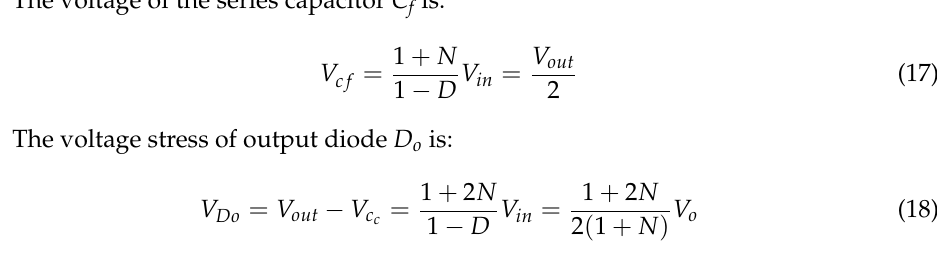
The relationship between output diode voltage stress and turns ratio is shown in Figure 7. The minimum output diode voltage stress ratio is 0.5. With the increase of turns ratio, the voltage stress increases. However, it always remains lower than the output voltage.